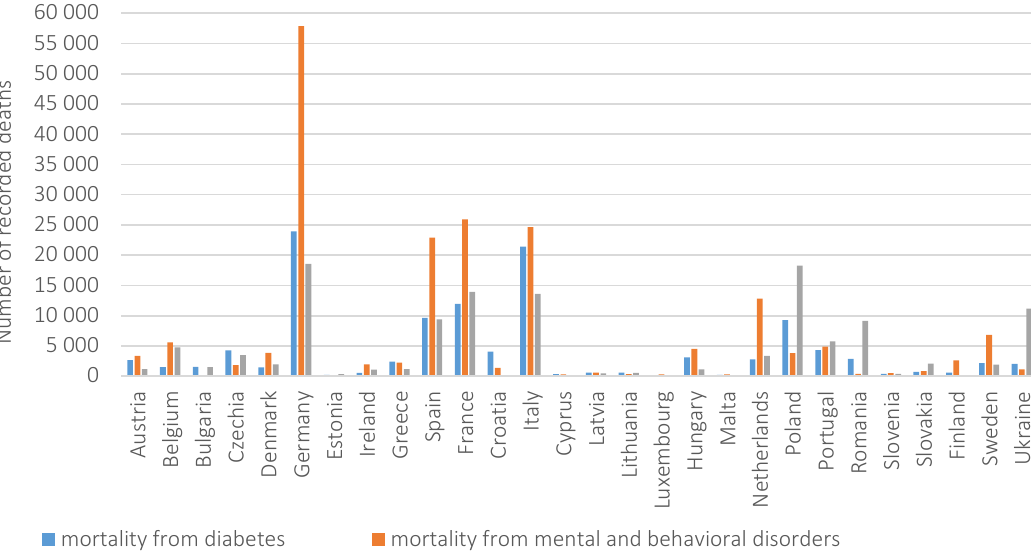
Figure 6. Comparative analysis of the EU countries and Ukraine by mortality rates from some dangerous diseases in